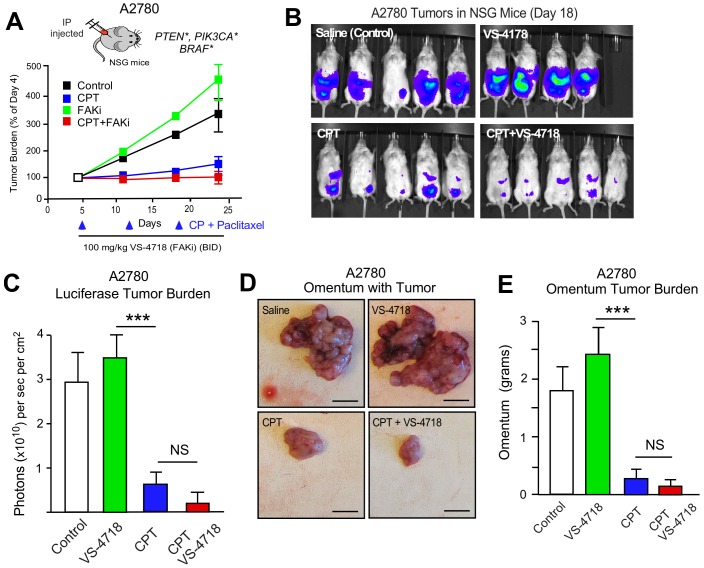
Inhibition of A2780 tumor growth by cisplatin-paclitaxel (CPT) chemotherapy.(A) Experimental schematic: Luciferase- and dTomato-expressing A2780 (*containing mutations in PTEN, PI3KCA, and BRAF) cells were injected intraperitoneally into immune-deficient mice and randomized at Day 5. Experimental groups were as follows: saline injection on Days 5, 12, and 19; VS-4718 alone (100 mg/kg, BID, oral gavage); CPT chemotherapy injection alone (3 mg/kg cisplatin and 2 mg/kg paclitaxel) on Days 5, 12, and 19; and VS-4718 plus CPT. IVIS imaging was performed on experimental Days 4, 11, 18, and 23. Tumor burden is expressed as percent of Day 4. (B) Representative images of tumor burden visualized by luciferase activity on Day 18. (C) Quantitation of tumor burden as measured by luciferase activity at Day 18. (D) Representative images of omentum with tumor from each treatment group at Day 24. Scale is 0.5 cm. (E) Omentum-associated tumor mass. (C and E) Values are means ± SEM (n = 6, ***p<0.001) from each treatment group. NS, not significant.